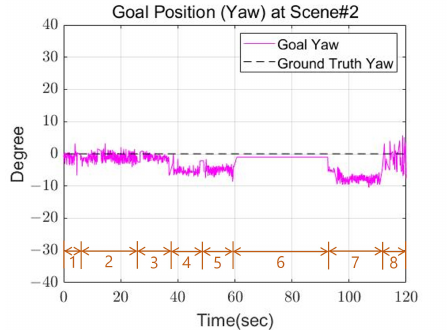
Figure 19. The goal orientation of Scene